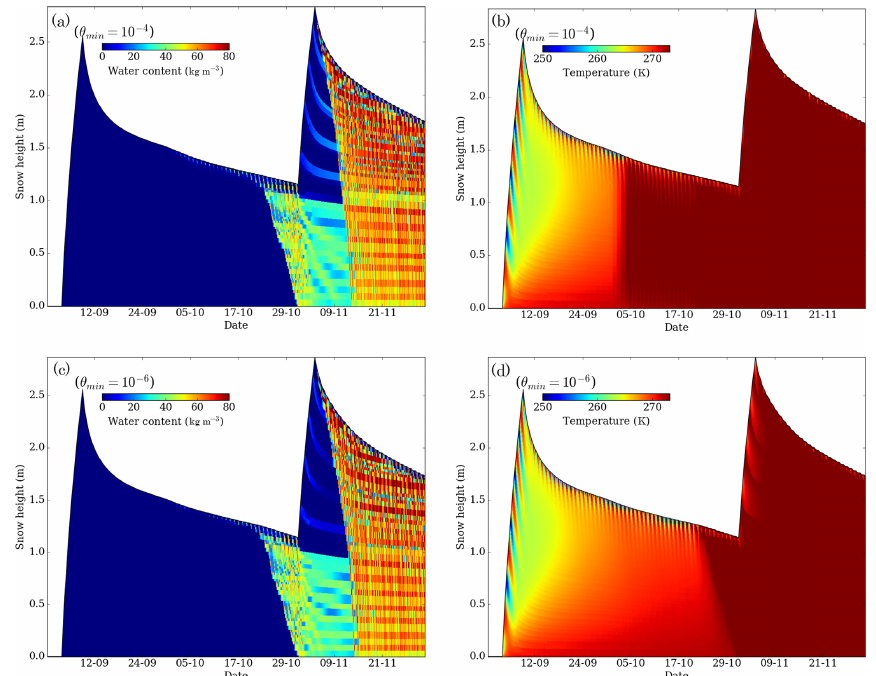
Figure C1. Water percolation and temperature evolution in the simulated data set with different prewetting amounts; plots use the free- flowing bottom boundary with prewetting set to θ min = 10 − 4 for (a) water content and (b) temperature and θ min = 10 − 6 for (c) water content and (d)